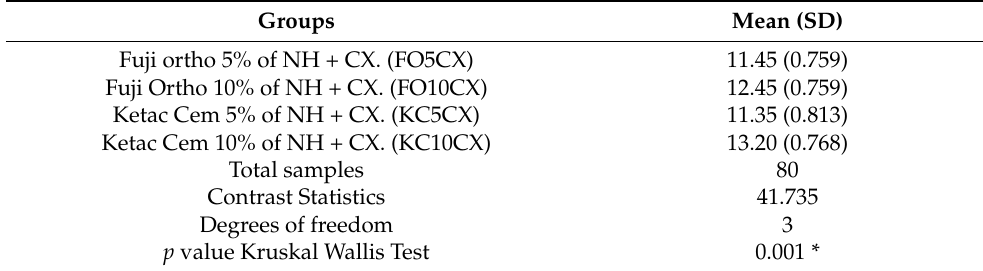
Table 1. Comparison of inhibitory effect from experimental groups analyzed in this study.